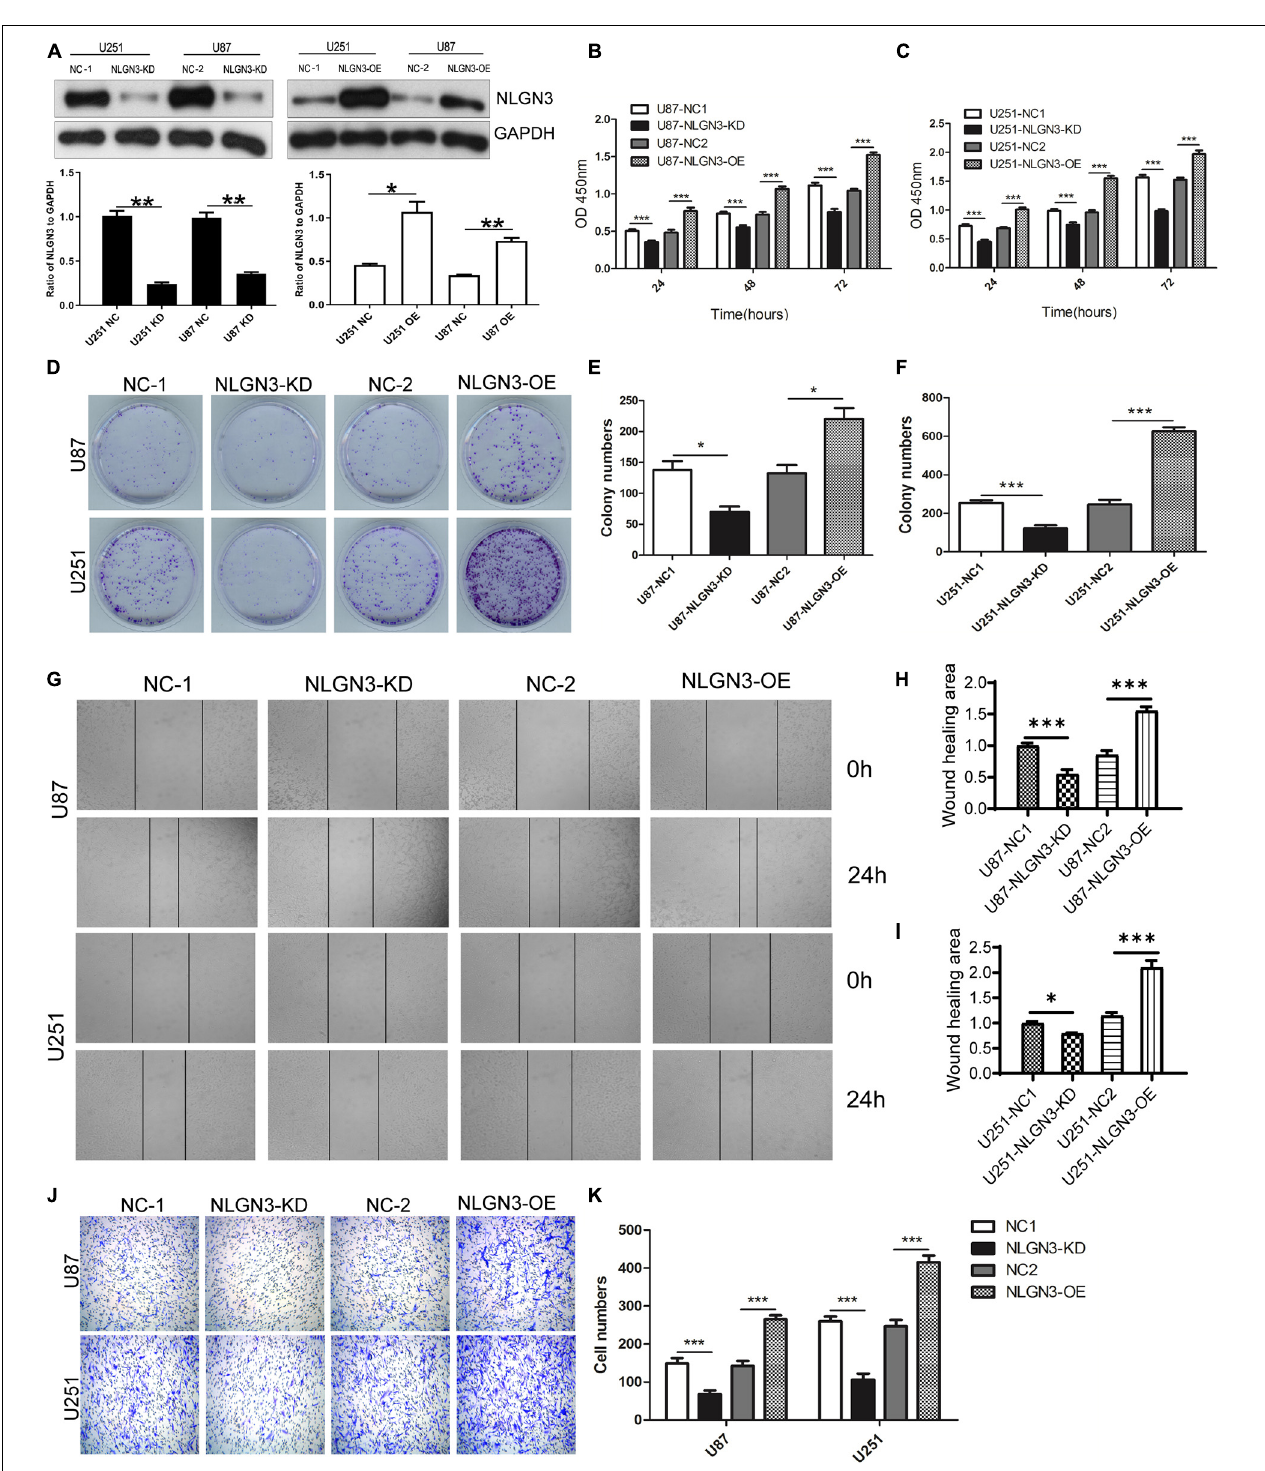
FIGURE 2 | NLGN3 promoted the proliferation and metastasis of glioma cells. (A) NLGN3-specific siRNA and an overexpression plasmid was transferred into glioma cells to generate NLGN3 knockdown and overexpression cell lines, respectively. Western blot was used to detect NLGN3 expression. CCK-8 assay was performed to determine the proliferation of U87 (B) and U251 (C) cells. (D) Colony formation assay was performed to further confirm the proliferation of U87 (E) and U251 (F) cells. (G) The migration of U87 (H) and U251 (I) cells was detected using wound healing assay. (J,K) The invasion of glioma cells was determined using transwell assay. NC, negative control group; KD, NLGN3 knockdown group; OE, NLGN3 overexpression group; * p < 0.05; ** p < 0.01; *** p < 0.001.